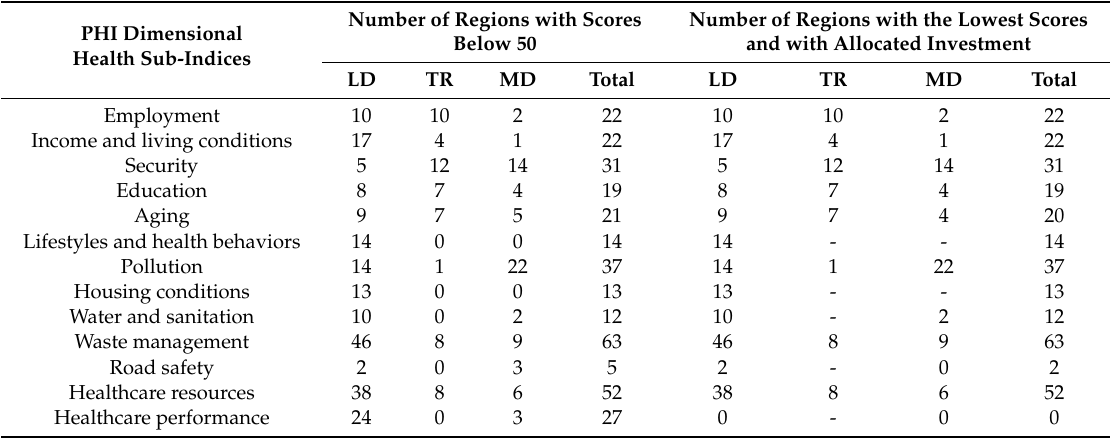
Table 5. Number of European Union (EU) regions with the lowest scores and with CP allocated investment, by category of region and dimensional health